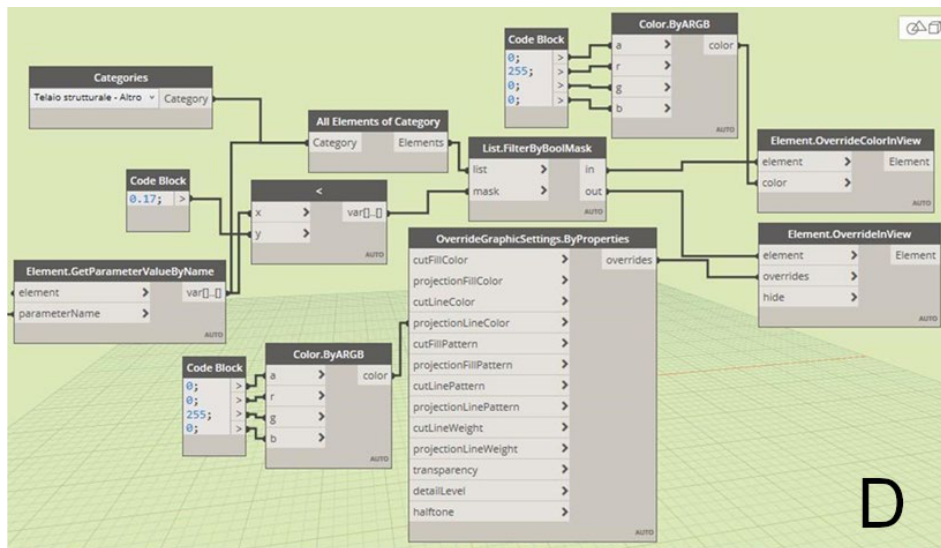
Figure 7. Element highlighting nodes.